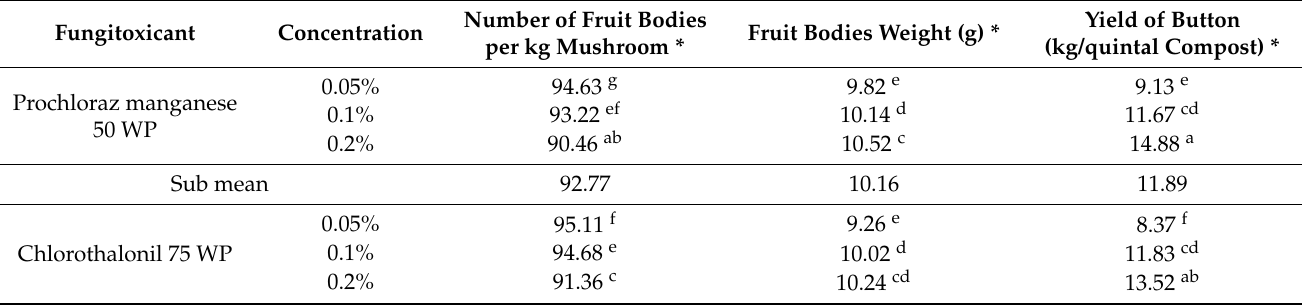
Table 5. Effect of non-systemic fungicides on T. harzianum infested casing pooled during spring, 2017 and 2018 on the number of fruit bodies per kg mushroom, fruit bodies weight (g) and yield of button (kg/quintal